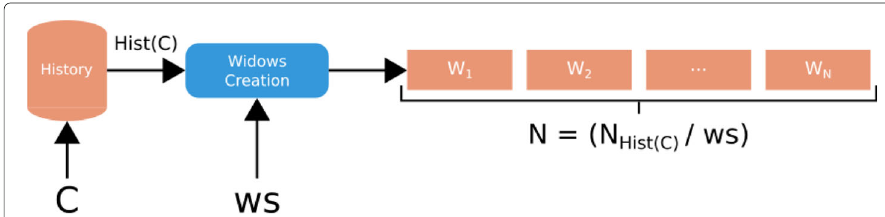
Fig. 2 Behavior sequence creation The behavior sequence is created by partitioning the list of transactions issued bt C in the History dataset into sequential windows of size ws